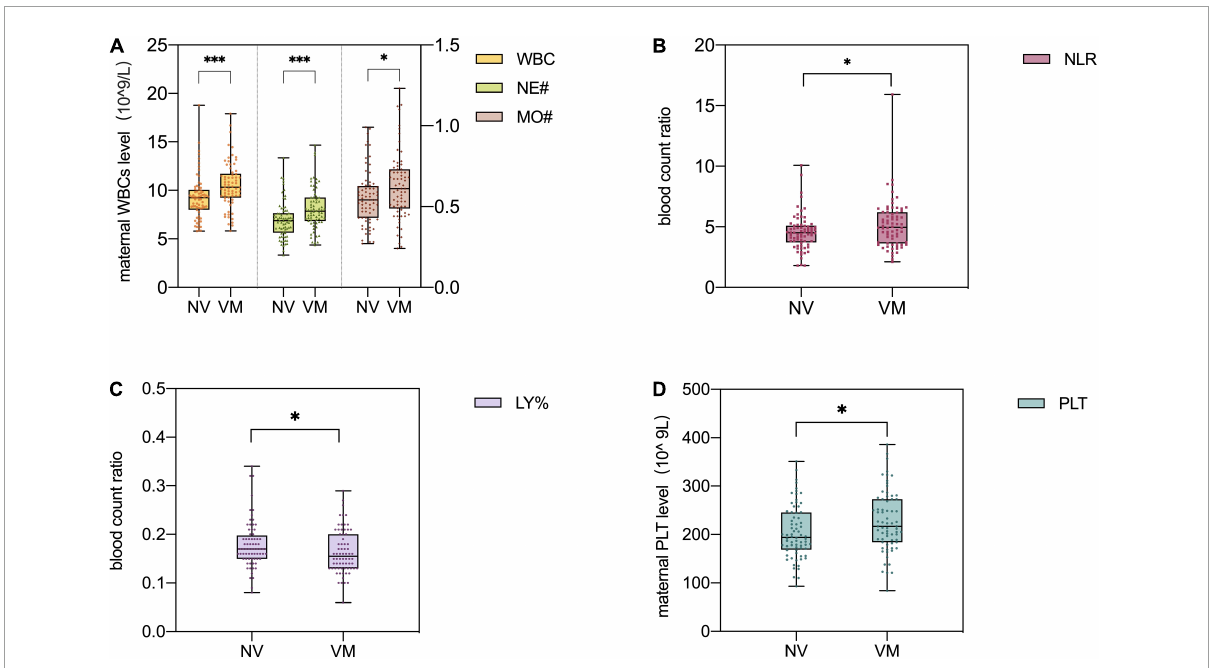
FIGURE3 Different levels of inflammation markers in maternal peripheral blood in the normal ventricular group ( n = 72) and fetal ventriculomegaly (VM) group ( n = 70). Mann–Whitney U test was used to compare the non-parametric data (A–C) and Student t -test was used for parametric data (D) . (A) Comparison of maternal white blood cell (WBC), neutrophil (NE#), and monocytes (MO#) levels among different groups. The maternal WBC and NE# levels are shown by the left Y-axis of the image, and the MO# level is shown by the right Y-axis of the image. (B) Comparison of the maternal neutrophil/lymphocyte ratio (NLR) among different groups. (C) Comparison of the maternal lymphocyte percent (LY%) among different groups. (D) Comparison of maternal platelet count (PLT) levels among different groups. NV, normal ventricles; VM, ventriculomegaly; WBC, white blood cell; LY%, lymphocyte percent; NE#, neutrophil; MO#, monocytes; NLR, neutrophil/lymphocyte ratio; PLT, platelet count. *** P < 0.001, ** P < 0.01, * P < 0.05. P -values less than 0.05 were considered statistically significant.